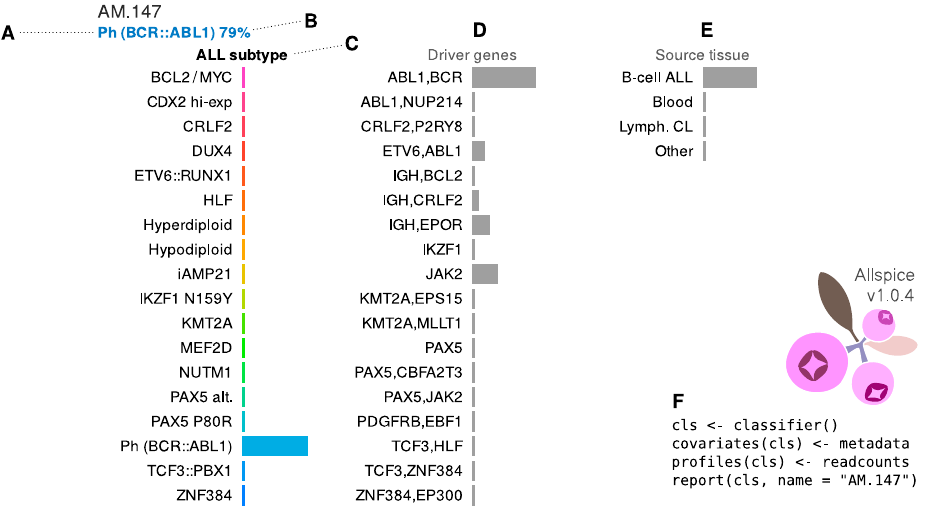
Figure 5. Example of a report card from the Allspice classifier for an adult male patient from North America with Philadelphia ( BCR::ABL1 ) genetic B-cell ALL subtype. ( A ) Sample identifier and predicted subtype based on RNA data in top-left corner. ( B ) The report shows the frequency of the corresponding genetic subtype in the training data, given the observed gene expression profile. In this case, there was a 79% chance that sequence and cytogenetics analyses would confirm the presence of the Philadelphia chromosome. ( C ) Visualization of how similar the sample is to each ALL subtype profile. The display can be interpreted as a panel of RNA “biomarkers” that are specific to each subtype. In this case, the high value for Ph indicates that the gene expression profile is compatible with a typical patient with the Philadelphia chromosome. ( D ) Allspice also indicates how similar the sample is to the RNA profiles associated with the presence of genetic alterations in one or more genes in parallel. In this case, the gene expression profile matches the typical profile of patients with independently verified BCR::ABL1 fusion (i.e., both BCR and ABL1 are altered). ( E ) Samples with high leukemia burden will typically produce a strong B-cell ALL signal in the tissue panel. ( F ) Minimal example of how to generate the report in the R programming environment.